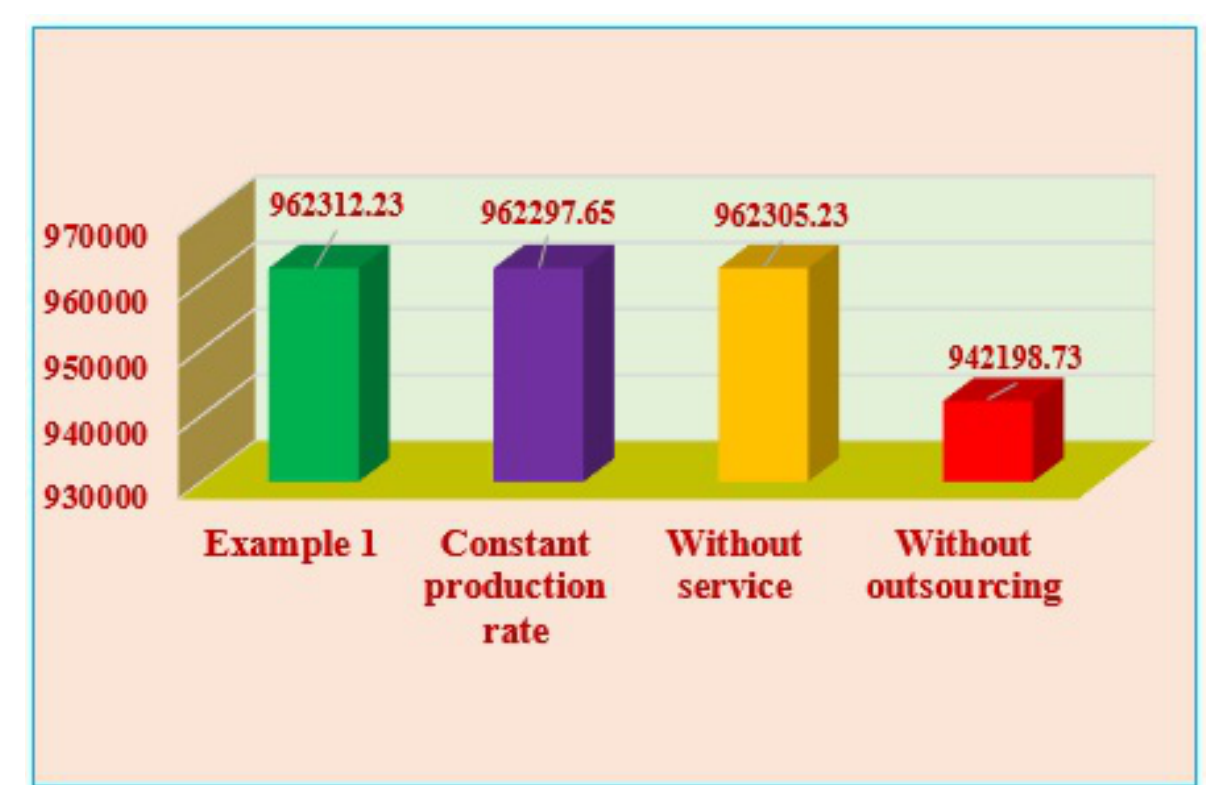
Figure 5. Comparison of the values of TEP obtained for Example 1 and its special